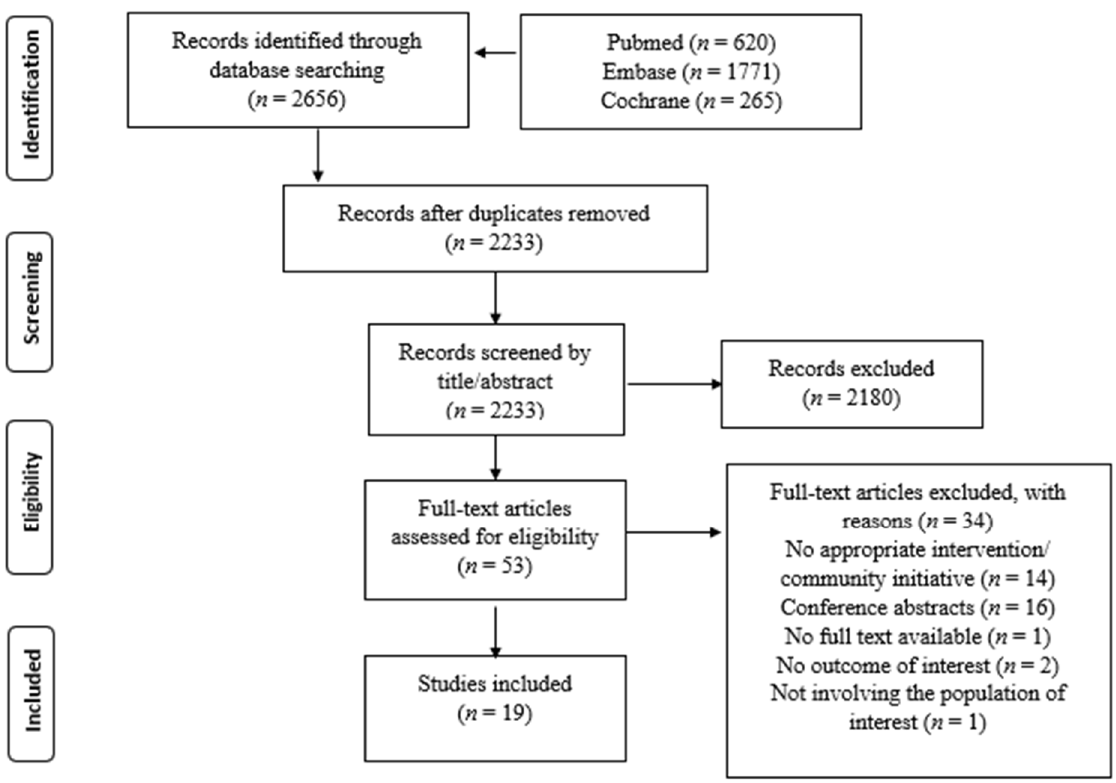
Figure 1. Flowchart of the screening process.